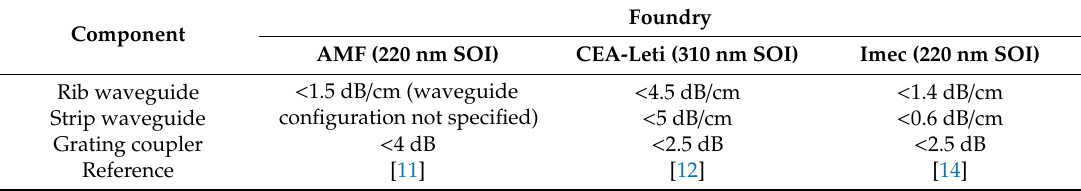
Table 3. Performance comparison with other major foundries. λ = 1.55 µm in all cases. Waveguide dimensions are not specified in the information published by the foundries.